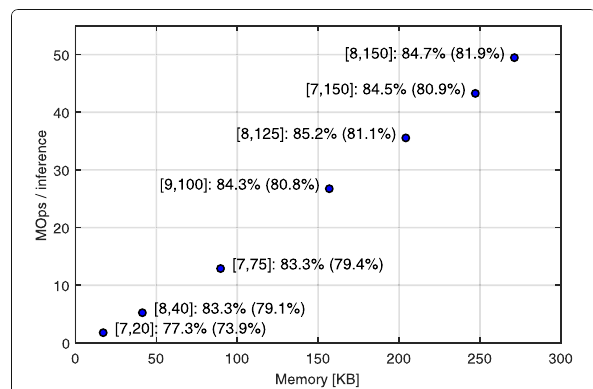
Fig. 8 Best performing networks of grid search for different memory and computational requirements